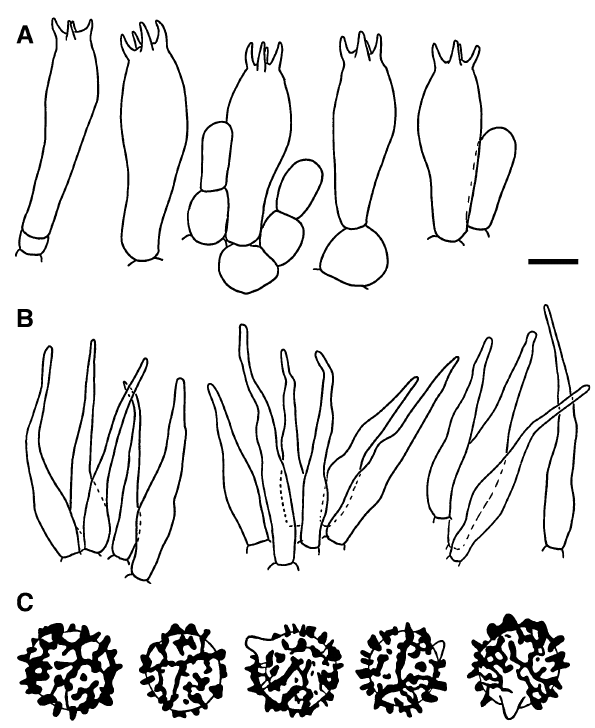
Figure 4. Hymenial elements of Russula bellissima (holotype, FH 12-127). ( A ) Basidia and basidiolae. ( B ) Marginal cells. ( C ) Spores as seen in Melzer’s reagent. Scale bar = 10 µm, but only 5 µm for